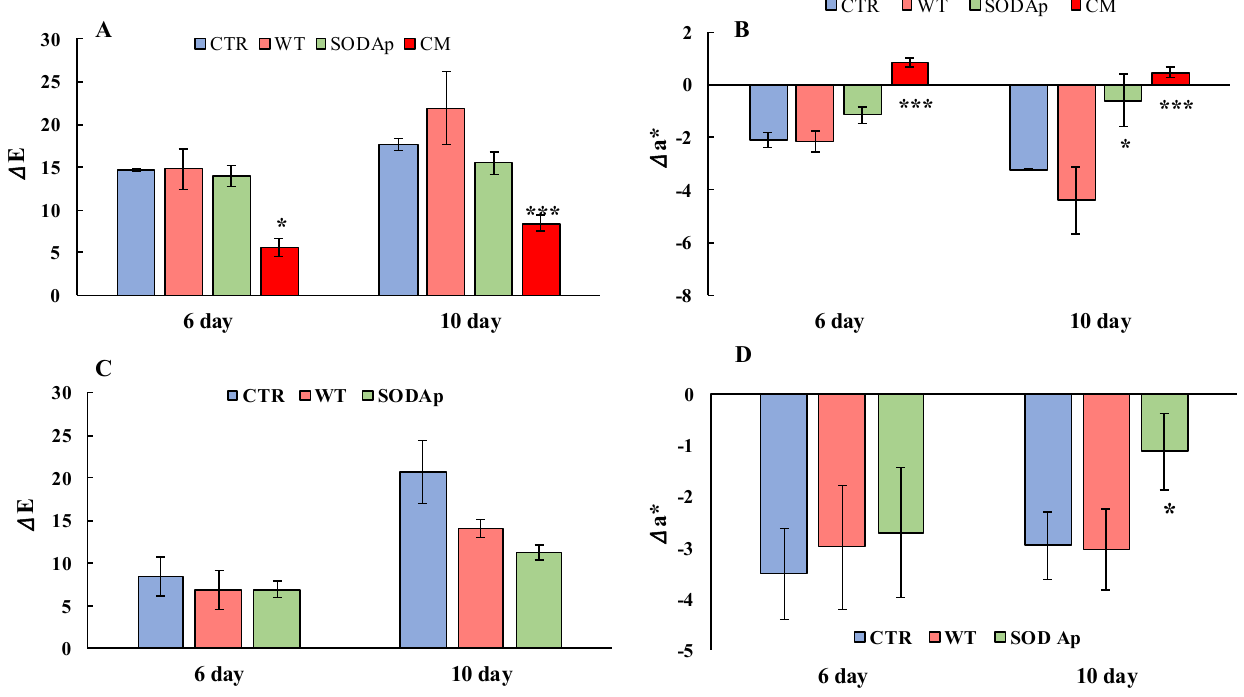
Figure 6. Analyses of total colour difference ( ∆ E ) and variation in a * ( ∆ a *) in Thunnus albacares and Thunnus thynnus fillets during the storage (4 ± 1 ◦ C) for 10 days. ( A ) ∆ E and ( B ) ∆ a * values in Thunnus albacares fillets injected with aqueous solutions containing water only (CTR: blue); extracts from tomato cell lines non-transformed with sod Ap (WT: light red); extracts from tomato cell lines transformed with sod Ap (SOD Ap : green); commercial brine (CM: red). ( C ) ∆ E and ( D ) ∆ a * values of Thunnus thynnus fillets injected with aqueous solutions containing water only (CTR: blue); extracts from tomato cell lines non-transformed with sod Ap (WT: light red); extracts from tomato cell lines transformed with sod Ap (SOD Ap : green). The measurements were conducted on the inner surface of the tuna fillets after 10 min exposure to air. Results are means of three independent experiments, and error bars represent the standard error (sem). * Significant difference ( p < 0.05) between the treated and the control samples. *** Significant difference ( p < 0.001) between the treated and the control samples.